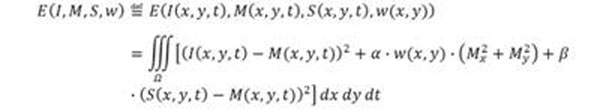
Definition of energy functional for the synthetic image estimation . Here I(x, y, t) is the acquired MOLLI image, and S(x, y, t) is the MOLLI signals which is calculated from the initial T1 parameter fitting. Note for the inversion recovery sequence, the polarity of acquired magnitude image has to be corrected. The weight function w(x, y) is added to maintain the edge sharpness in the estimated synthetic image. The first term constrains the distance between synthetic images and original MOLLI images. The second term is the regularizer using first-order derivative. It is added to penalize occasional error in the original T1 estimation and keep sufficient SNR of synthetic images. This term does not constrain the smoothness of the termporal behavior. The last term is added to minimize the distance between estimated images and the MOLLI signal recovery curve. As the MOLLI signal recovery curve is essentially smoothing, the term actually implicitly constrain the temporal smoothness of estimated synthetic images. α and β are weights to balance the contribution across three terms. This energy minimization problem can be solved by evaluating the resulting Euler equation.